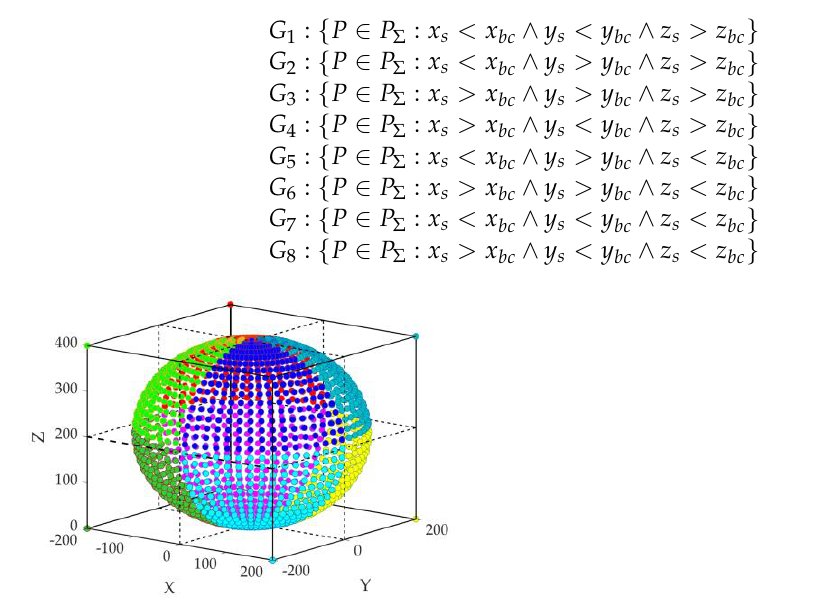
Figure 6. Space partition of the BB and BS.